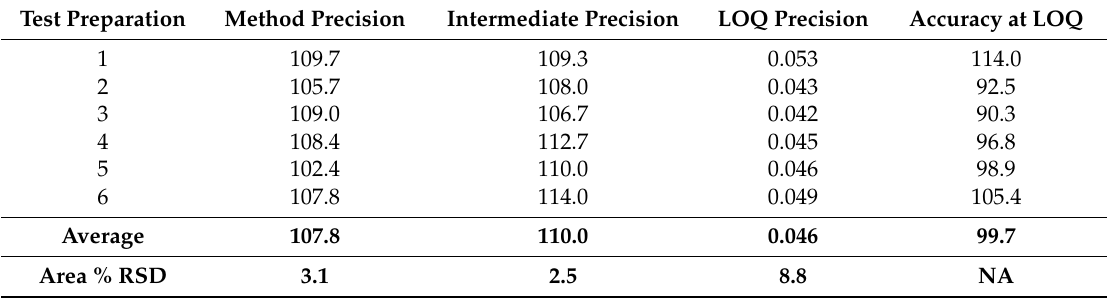
Table 4. Results of method—intermediate and limit of quantification (LOQ) precision and